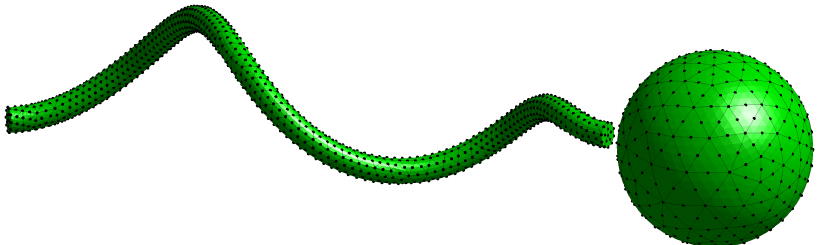
Figure 2. Schematic of the swimming organism used in all examples. It consists of a spherical body and a helical cylindrical flagellum. Note the surface discretization points, which are used in the boundary